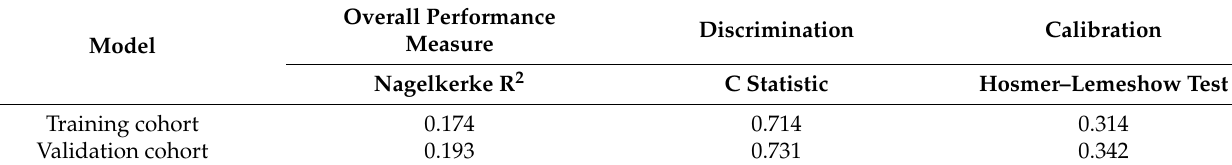
Table 4. The comparison of performance measures by using logistic regression mode in MVI probability.